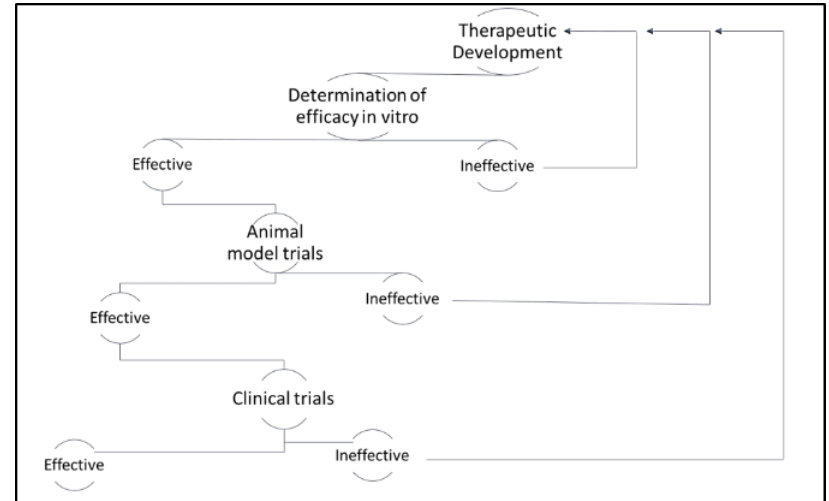
Figure 1. Diagram of therapeutic application post-therapeutic development. Therapeutics that are determined efficacious in vitro are applied in animal model trials. Therapeutics that are determined efficacious in animal model trials are applied in clinical trials. At any point, if the therapeutic is determined to be ineffective, researchers must return to the therapeutic development stage.